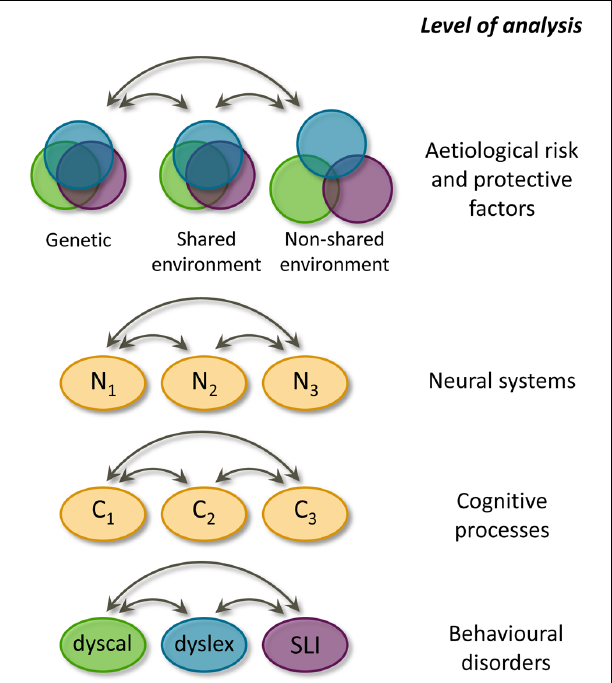
FIGURE 2 | Hybrid model for learning (dis)abilities, incorporating the generalist genes hypothesis (Kovas and Plomin, 2007) and the multiple deficit model (Pennington, 2006). Overlap at the aetiological level is graphically presented asVenn diagrams for each of the three sources of biometric variation. Double headed arrows indicate interactions. Causal connections between levels of analyses are omitted, N = neural system, C = cognitive process, dyscal = dyscalculia, dyslex = dyslexia, SLI = specific language